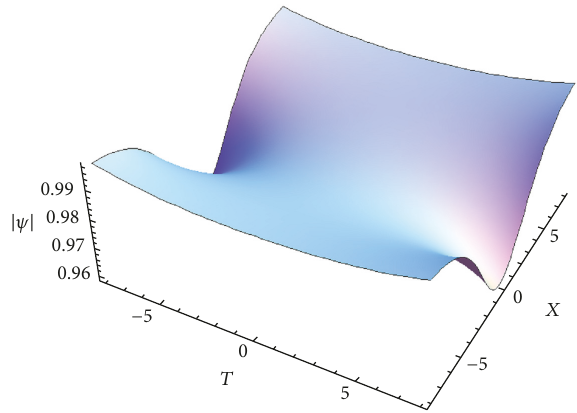
Figure 10: Spatial structure of the module of solution (81) with 𝑘 = 0.2 .